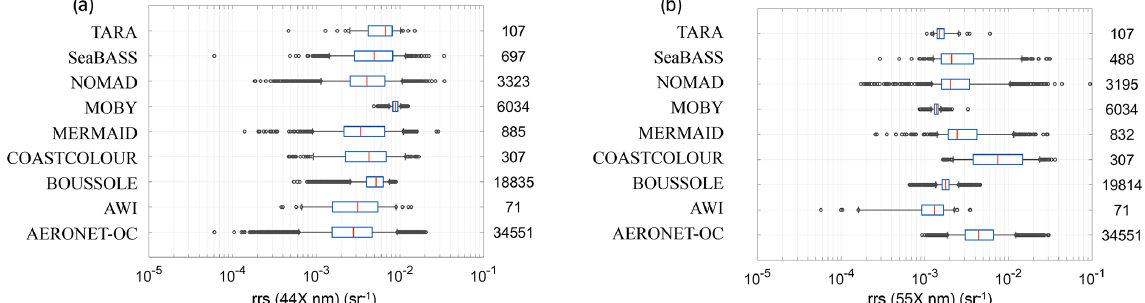
Figure 2. The distribution of (a) “rrs” at 44 X nm and (b) “rrs” at 55 X nm. Data were first searched at 445 and 555nm, and then with a search window of up to 8nm, to include data at 547nm. The black boxes delimit the percentiles 0.25 and 0.75 of the data and the black horizontal lines show the extension of up to percentiles 0.05 and 0.95. The red line represents the median value and the black circles the values below (and above) the percentile 0.05 (0.95). The number of measurements of each data set is reported on the right axis of the graph.